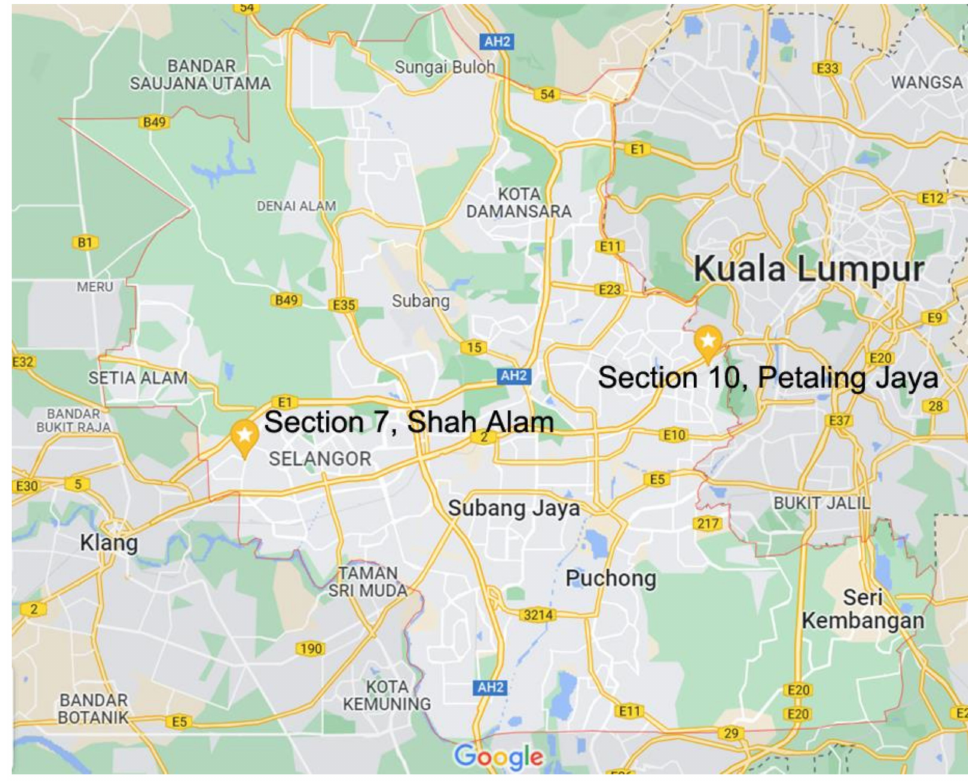
Figure 1. Map of Petaling district, with the two selected communities. (Source: Map data ©2022 Google, with